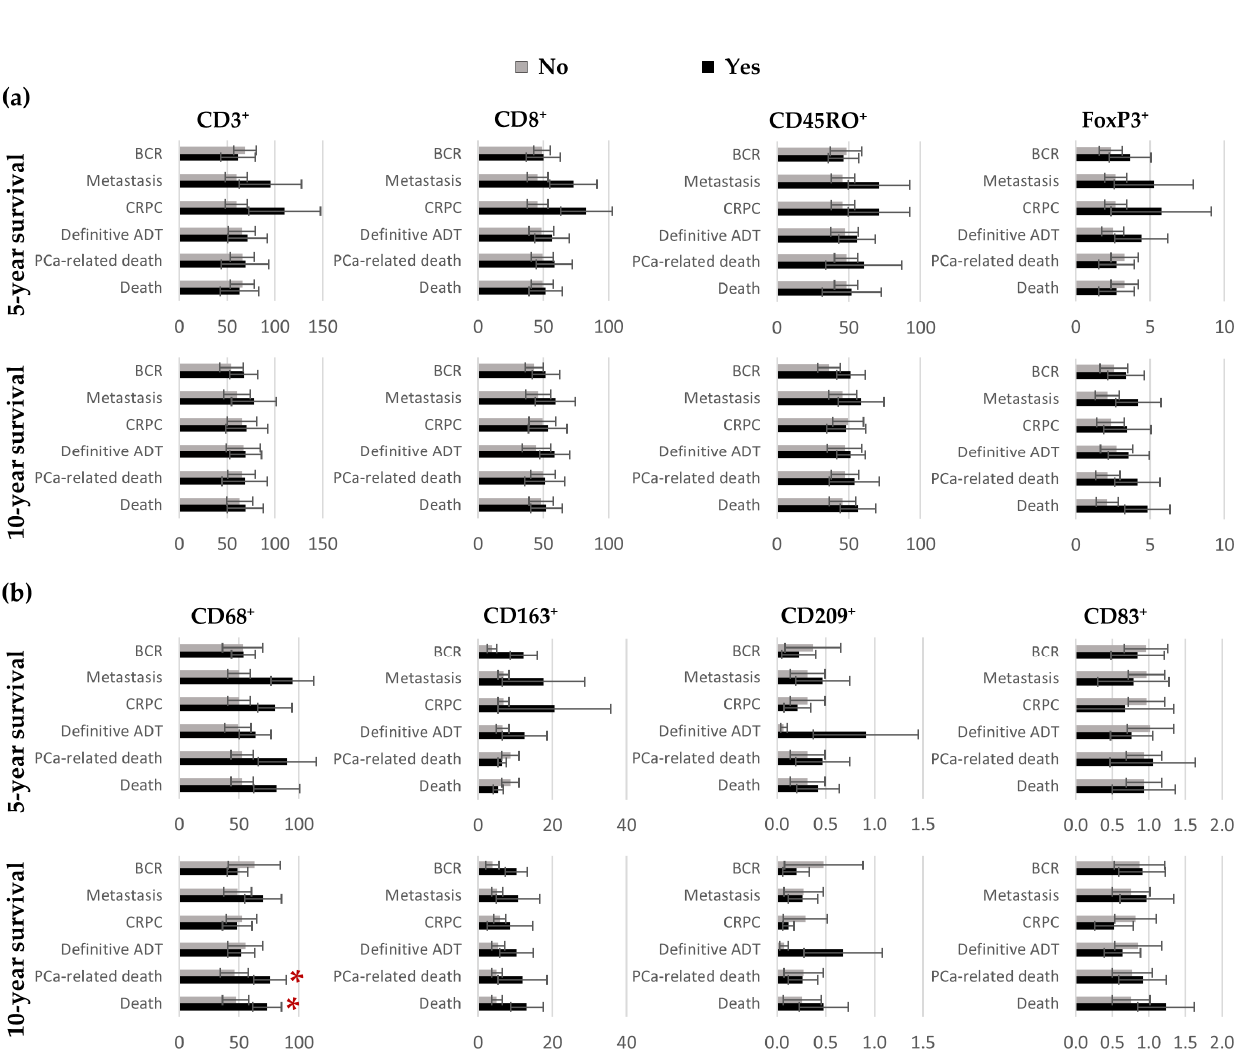
Figure 5. Bar charts representing the mean number of positive T cells ( a ) and antigen-presenting cells ( b ) in the total IDC-P according to patients’ outcomes five and ten years post-surgery. Error bars represent standard errors. For each cell marker, mean ranks according to survival status were compared using the Mann–Whitney U test and Benjamini–Hochberg corrections were applied to control for multiple comparisons. * Statistically significant p -values. ADT: androgen-deprivation therapy; BCR: biochemical recurrence; CRPC: castration-resistant prostate cancer; IDC-P: intraductal carcinoma of the prostate; PCa: prostate cancer.